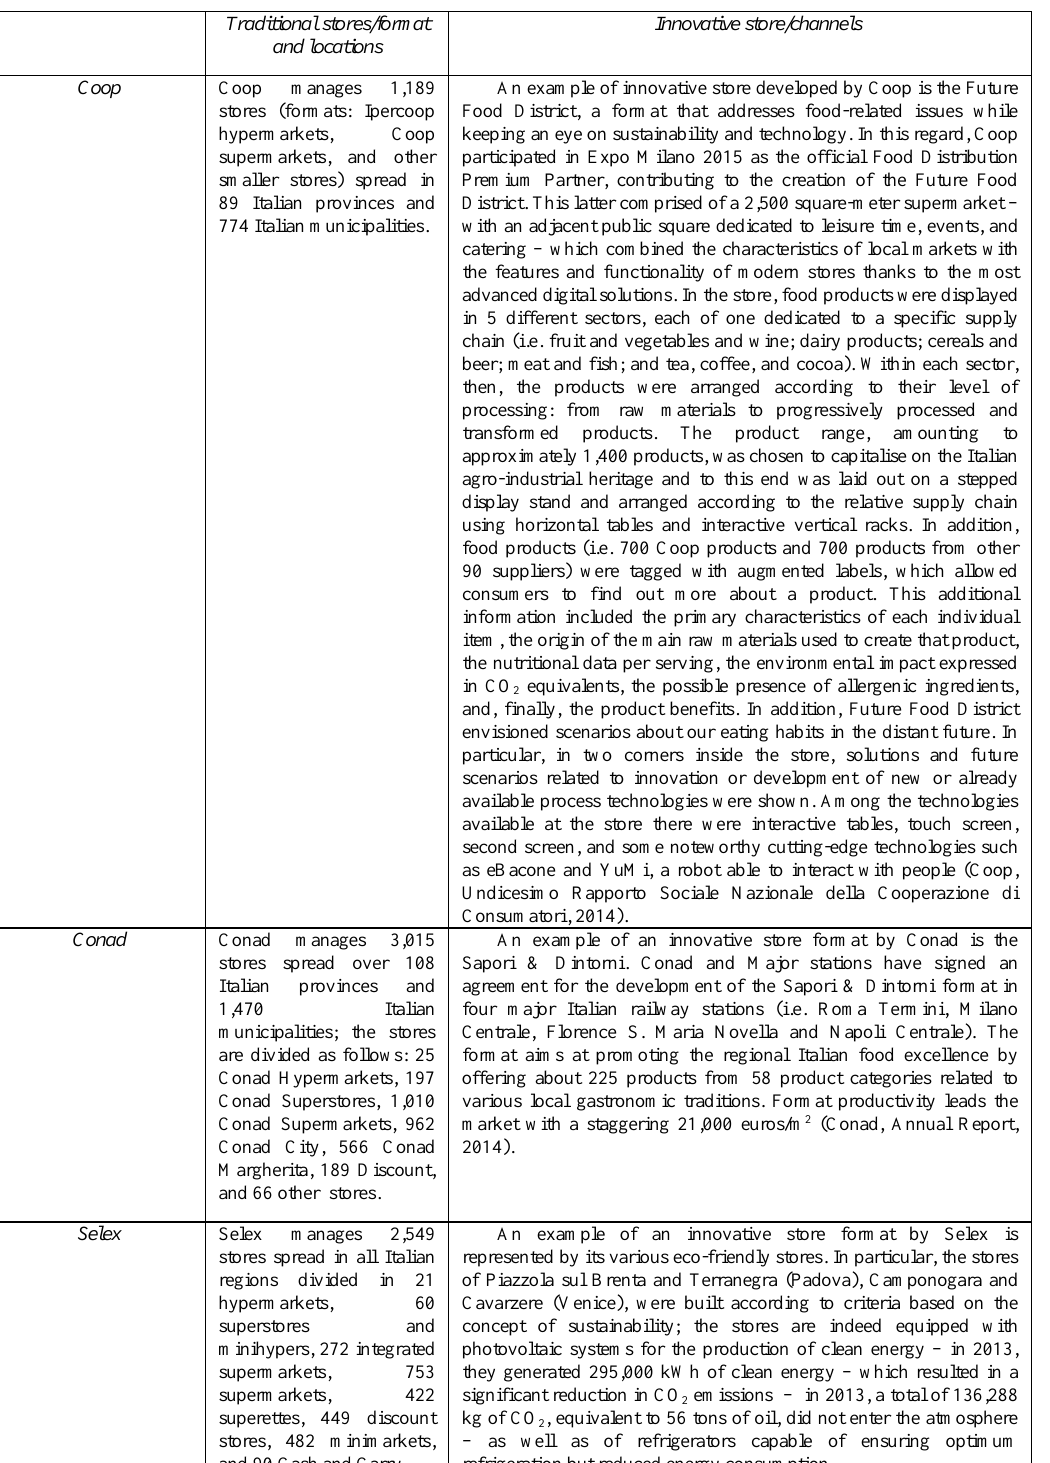
Table 8: Traditional Stores and some Innovative Store/Channels of the three Largest Italian Retailers Ranked by